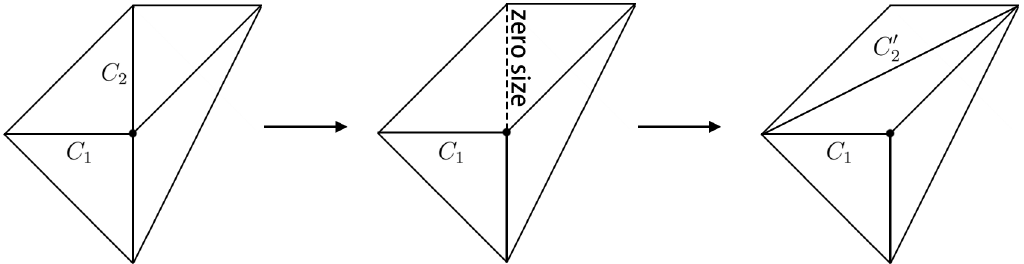
Figure 17 . The flop transition of F1 theory in terms of the toric